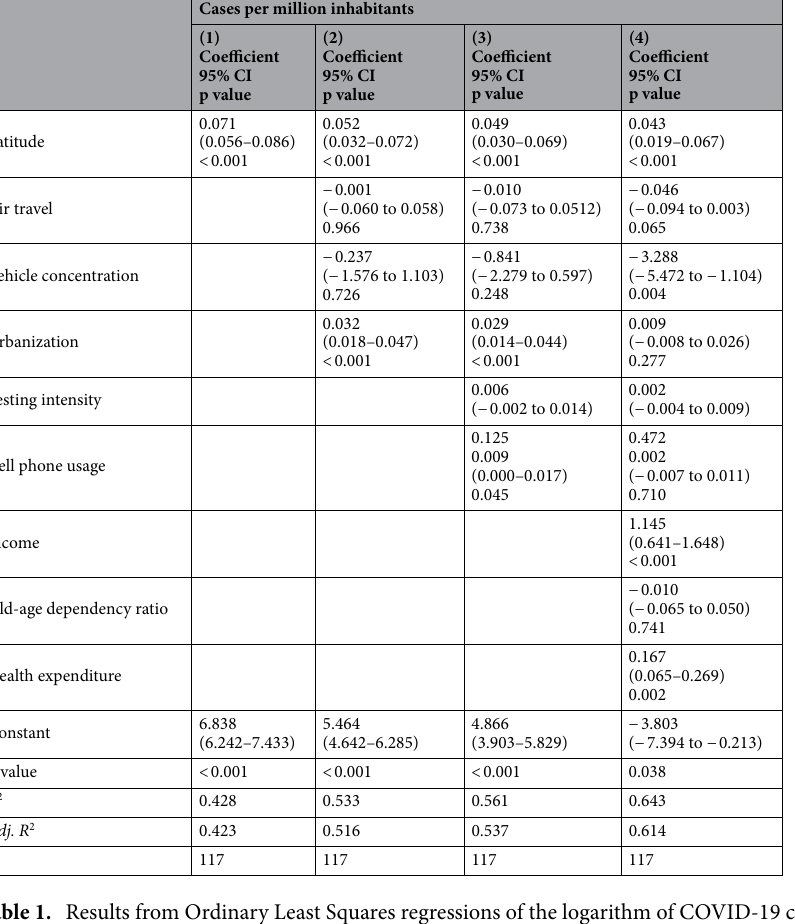
Table 1. Results from Ordinary Least Squares regressions of the logarithm of COVID-19 cases per million inhabitants in a country on the country’s latitude and control variables. Column 1 contains the bivariate specification of the regression of the natual logarithm of COVID-19 cases per million inhabitants on latitude. The other columns are nested models with control variables. Models (1) through (4) are alternative specifications and the results are based on countries in which more than 100 cases were reported as of January 9, 2021. Latitude is the absolute latitude of a country in degrees; air travel refers to the number of air passengers per capita in a country; vehicle concentration is the number of registered vehicles per capita; urbanization is the percentage of the population living in cities; testing intensity is the number of tests per hundred inhabitants; cell phone usage refers to the number of cell phones per capita; income refers to the purchasing power-adjusted per-capita gross domestic product (GDP) in a country; old-age dependency ratio is the ratio of the population above the age of 65 to the working-age population; health expenditure refers to the share of GDP spent on health. Robust standard errors are used to account for heteroscedasticity. Missing values were estimated with multiple (15) imputations. CI: confidence